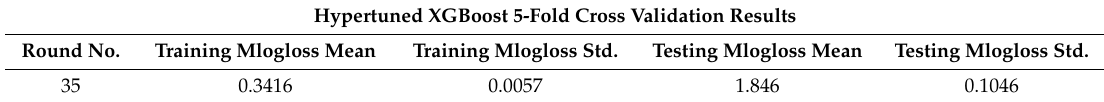
Figure 14. Word clouds displaying the highest terms found in each of the classes/labels for the 90 articles used to train the XGBoost classification algorithm. Word sizes scale to increase in size as they increase in frequency. Table 2. XGBoost text classification model cross-validation performance